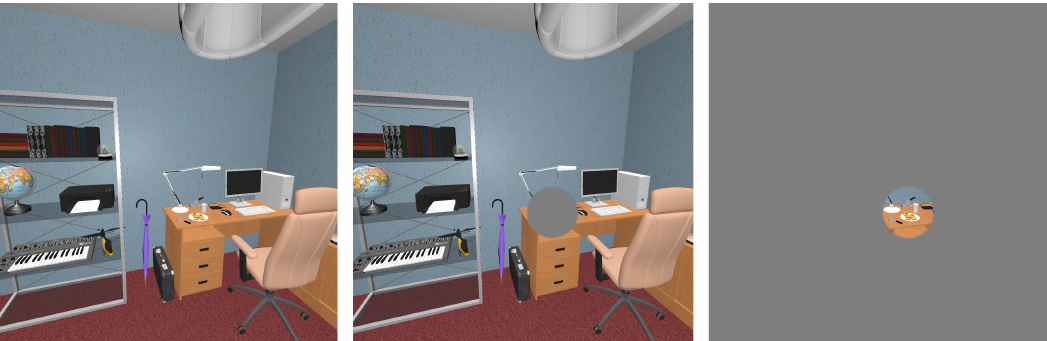
Figure 2. Masking conditions are presented here in a viewport measuring 90 by 90 deg. of field of view, mask radii are proportionally accurate. From left to right: control no-mask condition, central mask of six deg. of radius, peripheral mask of six deg. of